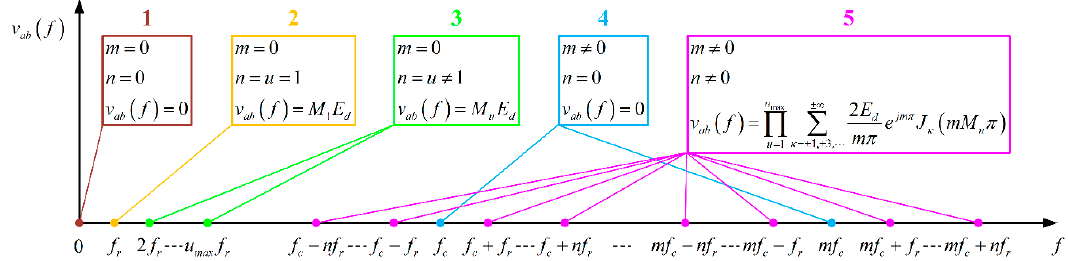
Figure 4. Analytical expressions of the v ab spectra.